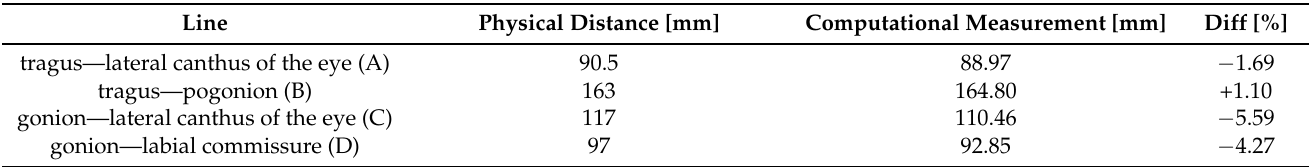
Table 1. Demarcation lines measurements for Figure